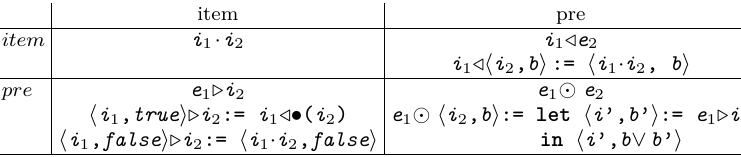
Fig. 3. Concatenations between items and PREs and respective